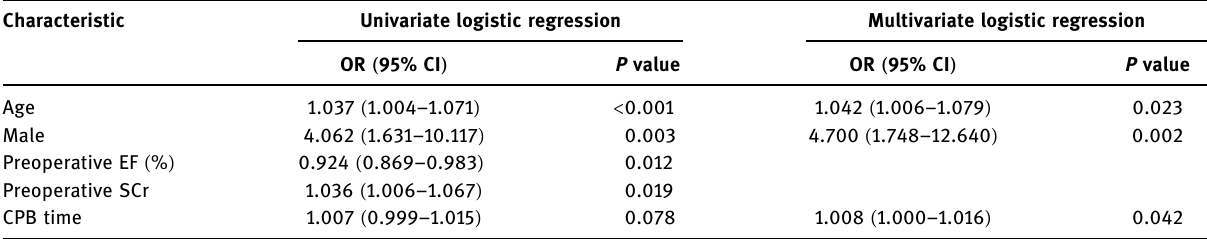
Table 3: Logistic regression analysis for postoperative